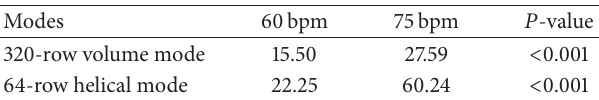
Table 5: The effect of heart rate variation on the absorbed radiation dose (mGy) for both